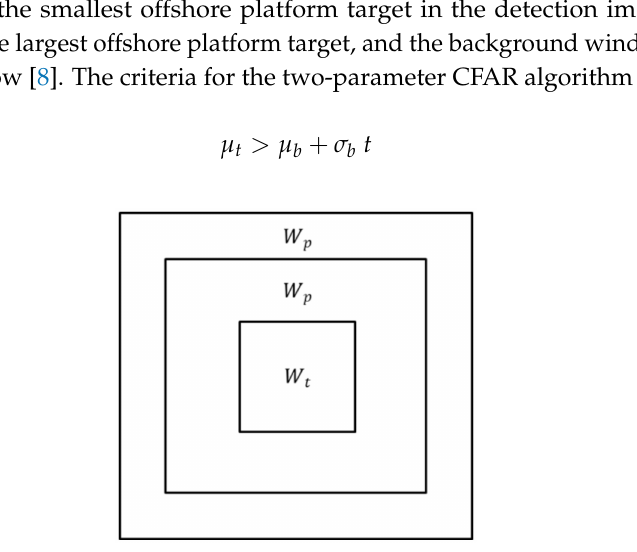
Figure 1. A schematic diagram of the two-parameter constant false alarm rate (CFAR) detection window, where W b represents the background window, W p represents the protection window, and W t represents the target